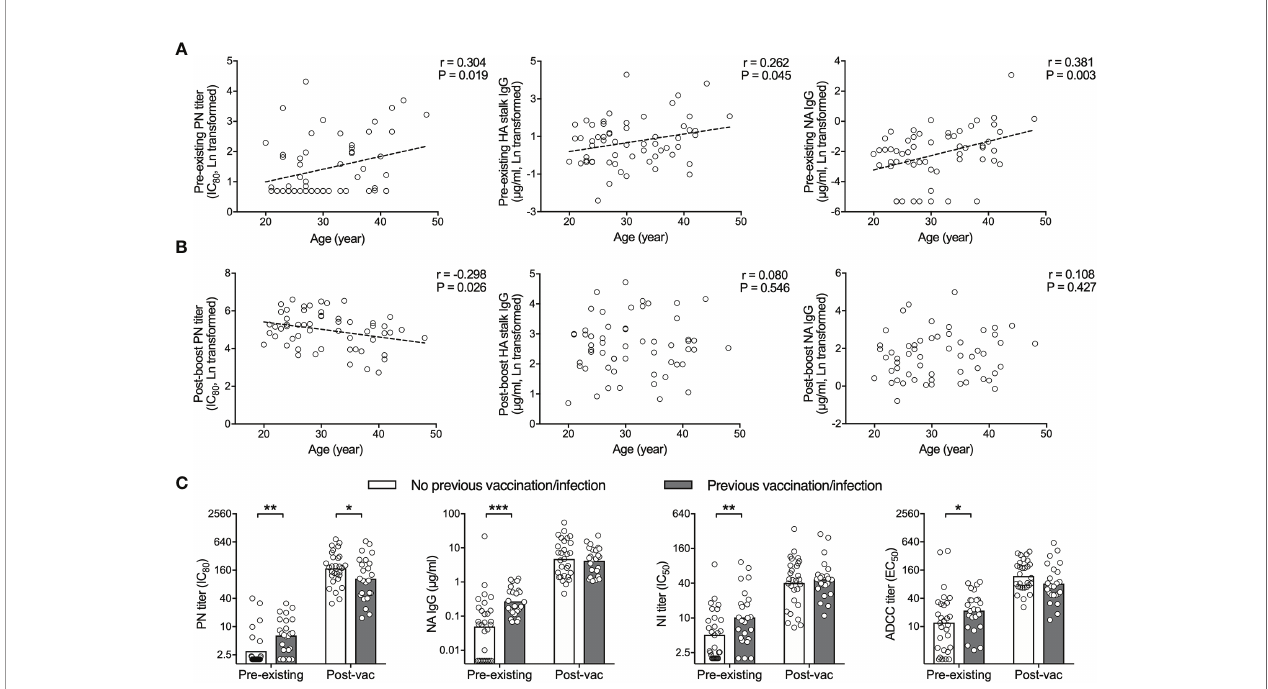
FIGURE 3 | H5N1 vaccines elicit potent antibody responses regardless of pre-existing humoral immunity. (A, B) HA speci fi c neutralizing antibodies (PN titer, left), total HA stalk speci fi c antibodies (IgG, center) and total NA speci fi c antibodies (IgG, right) tested in pre-vaccination sera (pre-existing, D0, A ) correlate with age. Inverse or no signi fi cant correlation with age is found in sera after vaccination (post-vac, D42, B ). (C) Subjects with previous vaccination and/or infection had signi fi cantly higher pre-existing antibodies, compared to subjects without previous vaccination or infection. After vaccination, the difference was abolished. HA speci fi c neutralizing antibodies (PN titer, far left), total NA speci fi c antibodies (IgG, central left), neuraminidase enzymatic activity inhibiting antibodies (NI titer, central right), and antibody-dependent cell-mediated cytotoxicity (ADCC) inducing antibodies (ADCC titer, far right) were tested in sera before (pre-existing) and 42 days after vaccination (post-vac). The geometric mean titers are shown as bars (C) , and each symbol represents one subject (A – C) . Linear fi tting curve was plotted as dotted line when Pearson correlation P < 0,05. Pearson r and P values are noted for each correlation (A, B) . *P < 0.05, **P < 0.01, ***P < 0.001 (Antibody titers and concentrations were Ln transformed in statistical analyses. Fisher ’ s LSD test between subjects with previous vaccination/infection and subjects without was performed in two-way ANOVA in (C)